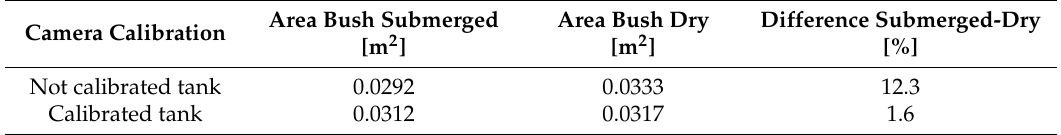
Table 3. Bush area using the endoscope camera in the plastic water tank.